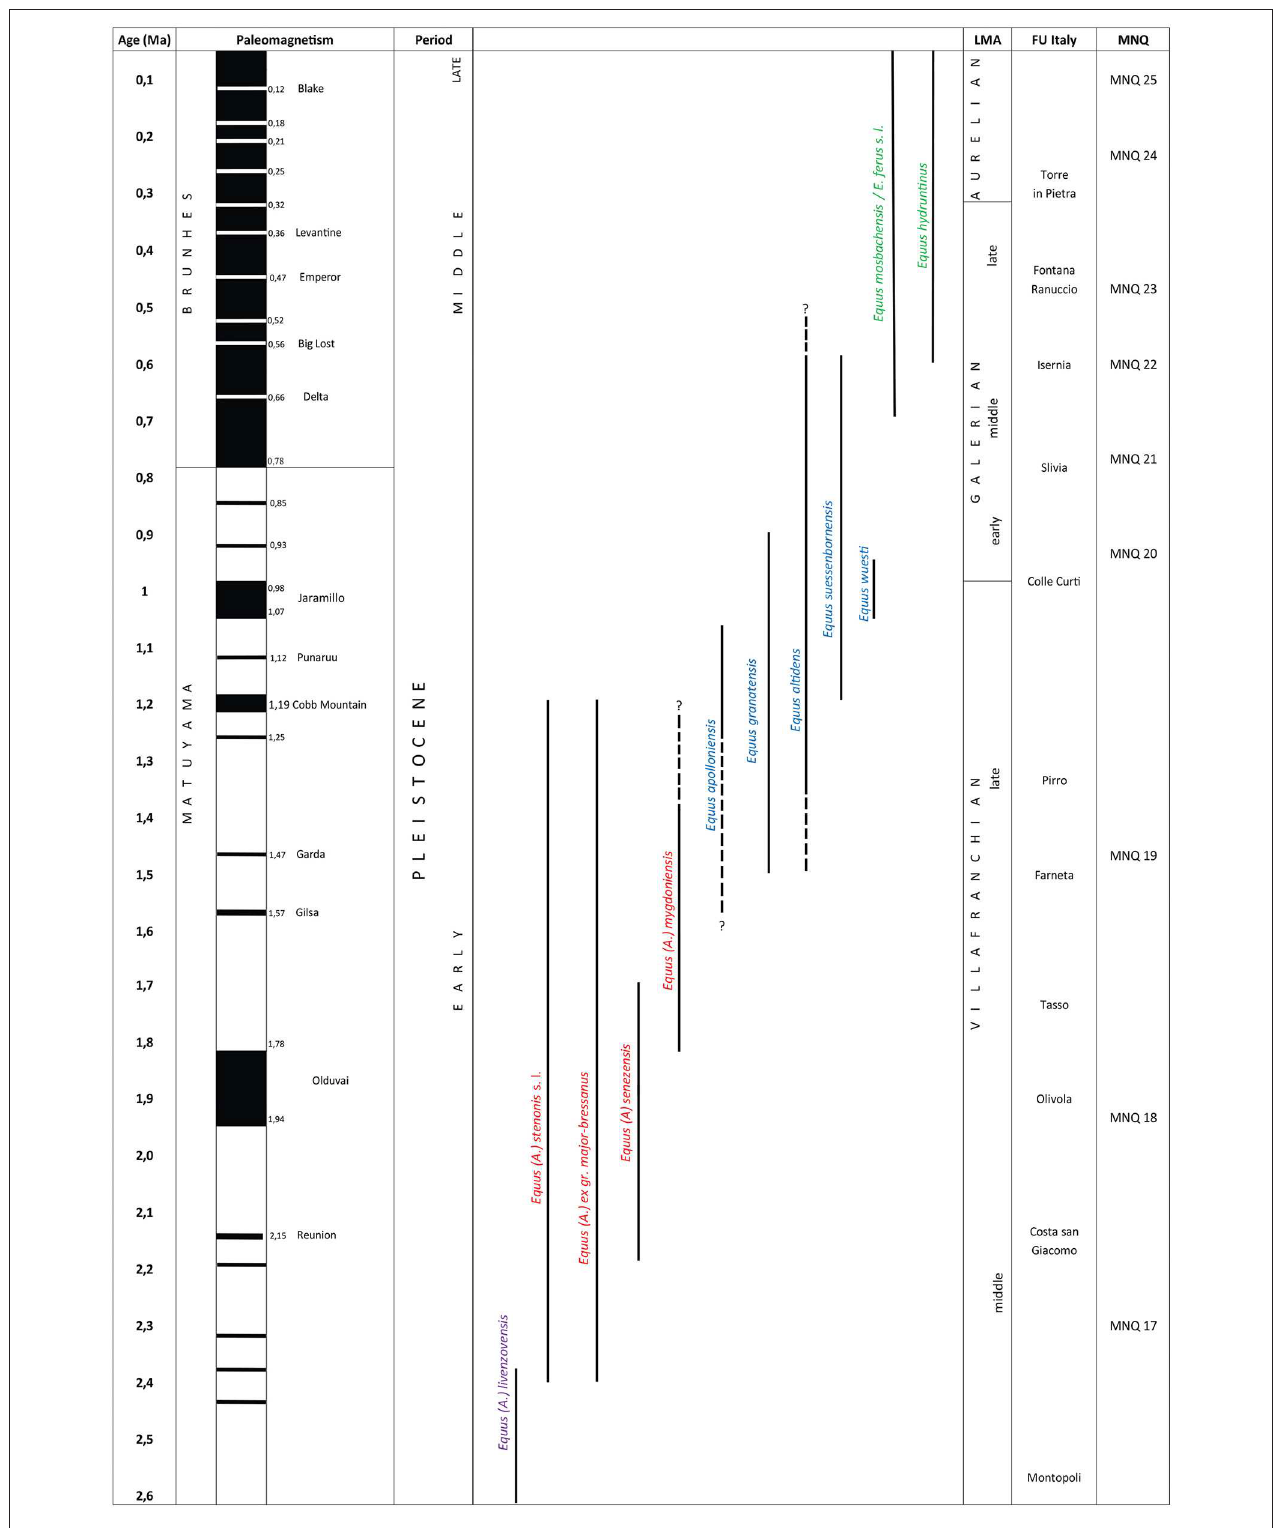
FIGURE 1 | Biochronological overview of the genus Equus s. l. from Europe.